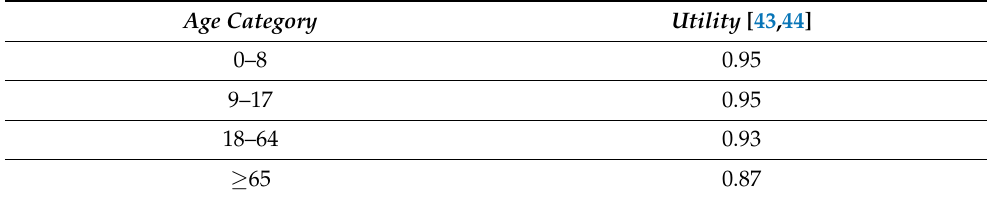
Table 10. Utilities (for healthy